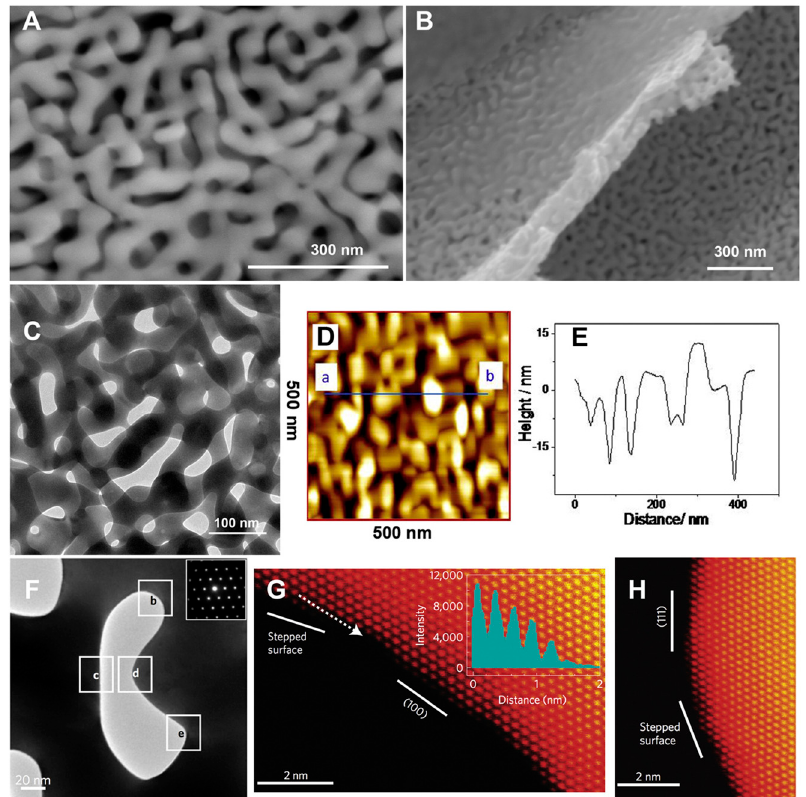
Figure 4. Main view ( A ) and side view ( B ) scanning electron microscope (SEM) images of a nano-porous gold (PG) leaf; ( C ) transmission electron microscope (TEM) image of nano-PG; ( D ) Contact mode atomic force microscope (AFM) images of nano-PG. Scan area: 500 × 500 nm 2 . ( E ) Height profile of a cross section along the line as indicated by a and b in ( D ); ( F ) TEM image of a [01] nanopore and the corresponding di ff raction pattern (inset); ( G ) High-angle annular darkfield-scanning TEM (HAADF-STEM) image of the labeled square indicated as b in ( F ). The intensity profile (inset) along the dotted line represents a stepped surface; ( H ) HAADF-STEM image of the labeled square indicated as d in ( F ). Reproduced with permission from [60]. Copyright Elsevier Ltd., 2016.